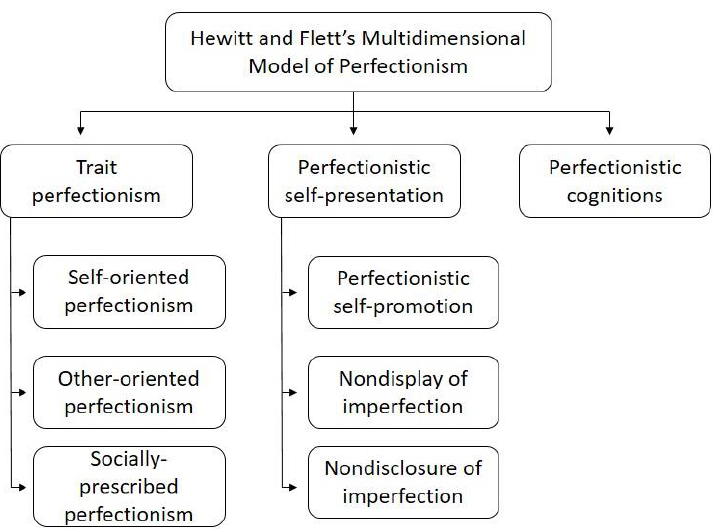
Figure 1. Hewitt and Flett’s Multidimensional Model of Perfectionism.